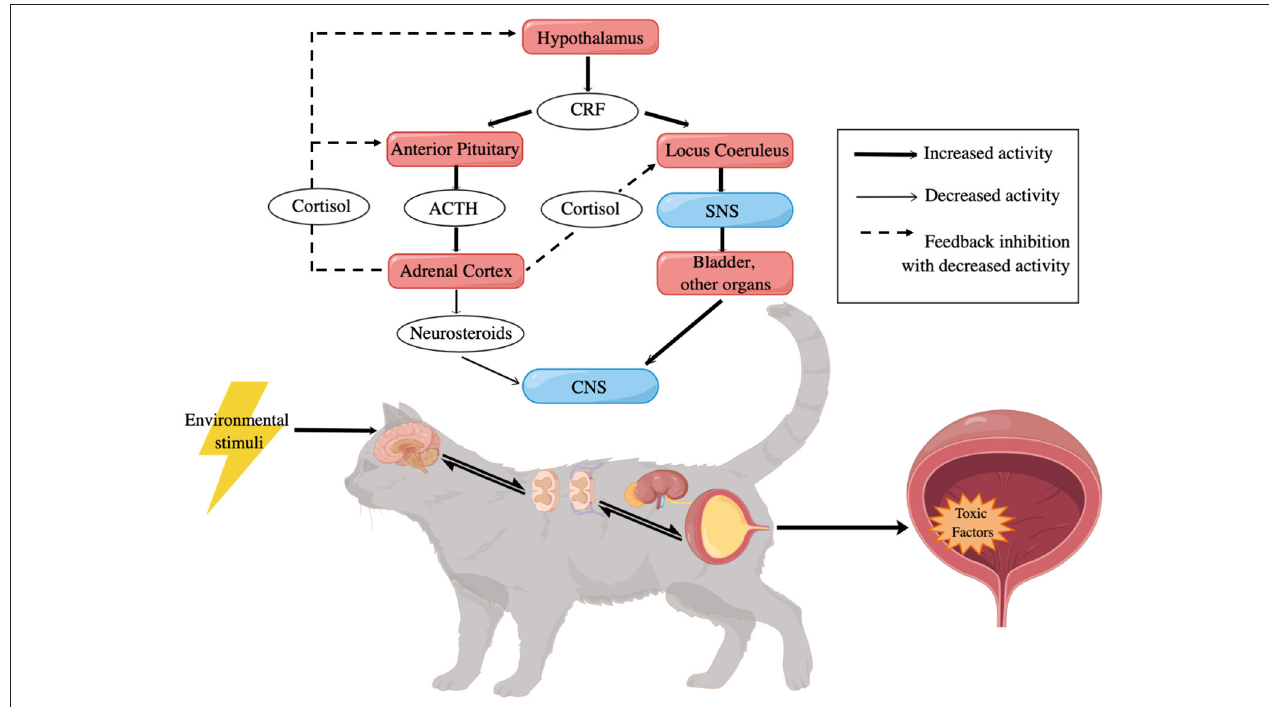
FIGURE 2 | Potential pathogenesis of FIC [adapted from Hosutler et al. (9)]. CRF, corticotropin releasing factor; ACTH, adrenocorticotropic hormone; SNS, sympathetic nervous system; CNS, central nervous